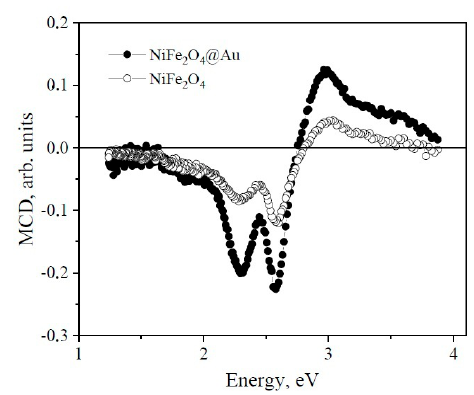
Figure 6. Room-temperature magnetic circular dichroism (MCD) spectra of NiFe 2 O 4 and NiFe 2 O 4 @Au (three-stage coating) NPs recorded in magnetic field of 10 kOe.